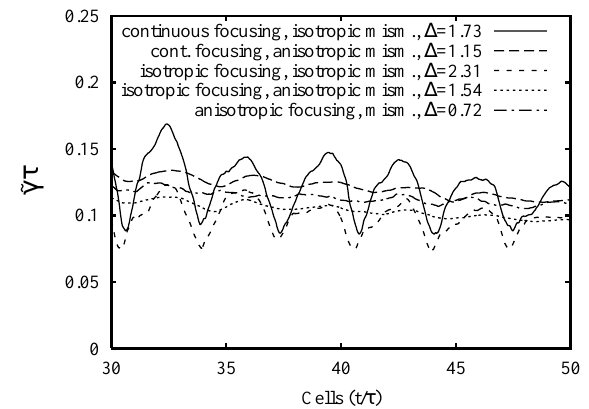
FIG. 9. Normalized friction coefficients ˜ gt for 2500 simula- tion particles versus the number of cells obtained by 3D simu- lations of different focusing systems and matching conditions at s 0 (cid:1) 60 ± , s (cid:1) 15 ± per cell, for a normalized correlation time dt (cid:1) t (cid:1) 0.475